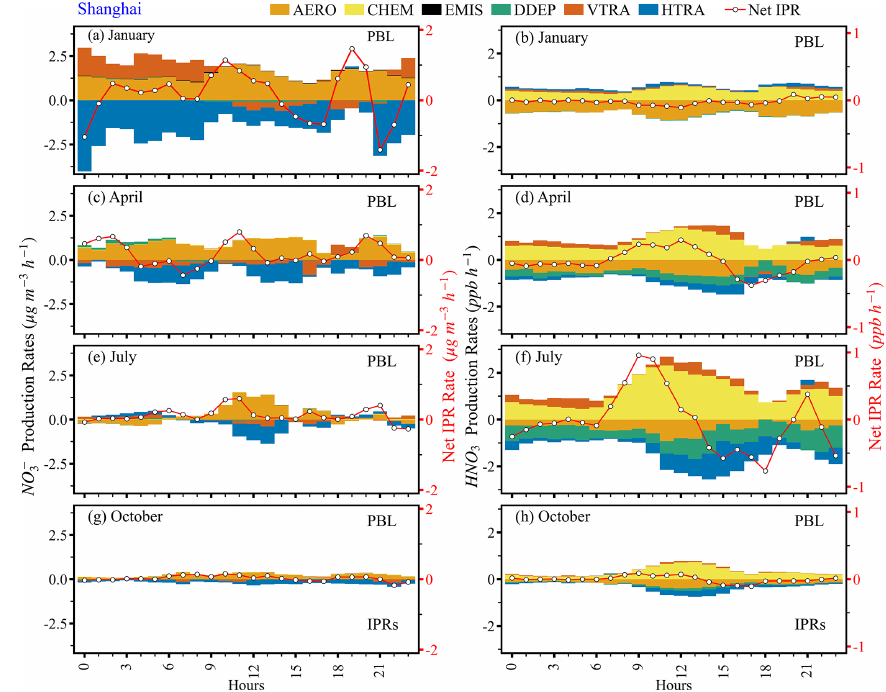
Figure 5. Diel variations in physical and chemical processes rates of NO 3 − and HNO 3 production (a–h) within the PBL in Shanghai. The red line represents the net IPR value for each hour of the day; its value scale is on the right y axis.